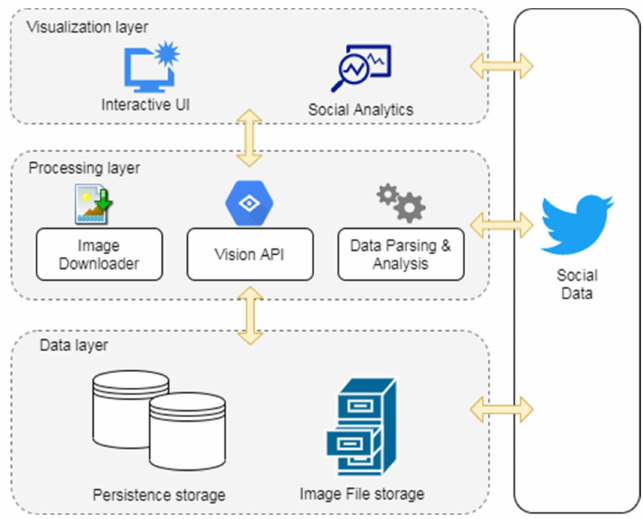
Figure 1. The three-layered architecture of our proposed